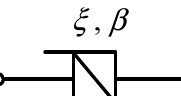
Figure 1. Constant order fractional viscoelastic element.